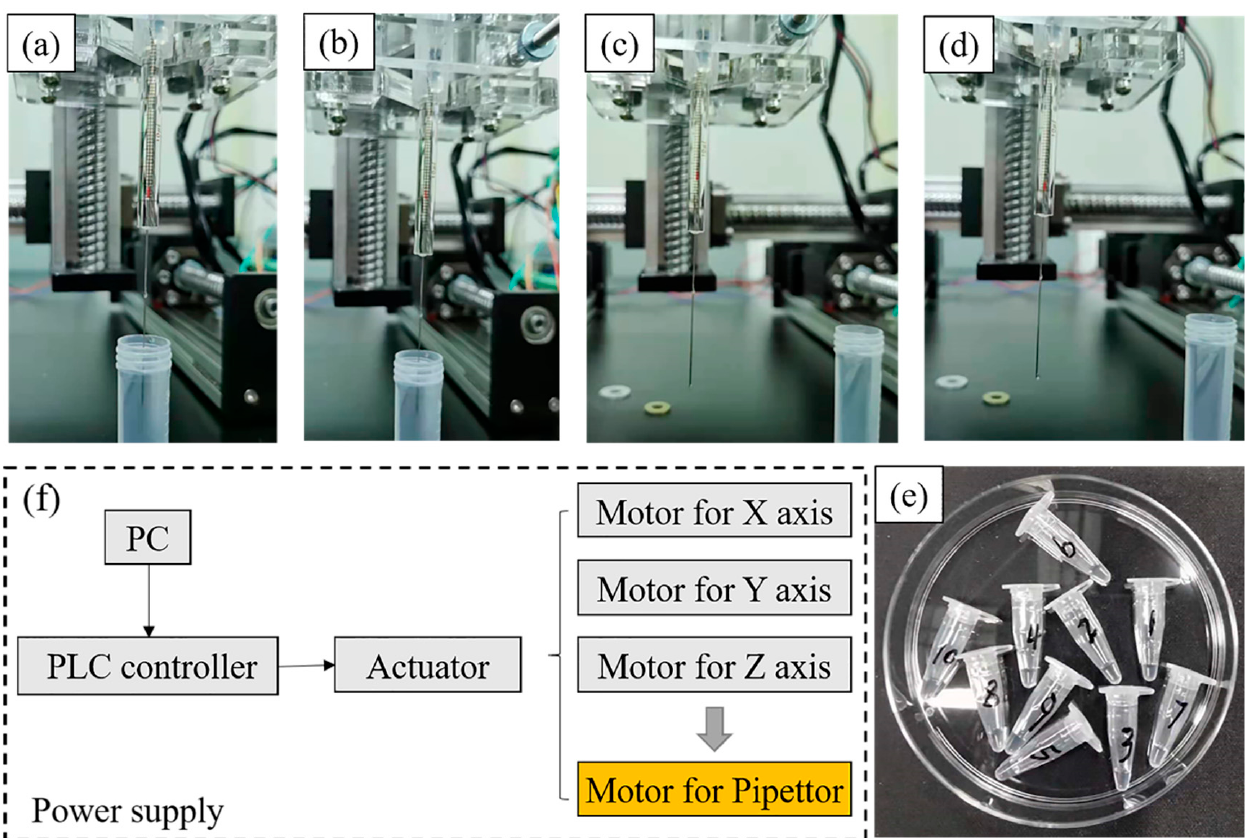
Figure 2. The process of suction and discharge from ( a – d ), ( e ) is the Eppendorf tubes used for collecting liquid, ( f ) is the basic principle of the equipment.